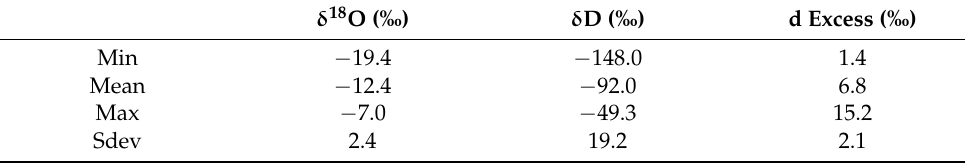
Table 3. Basic statistics of the stable water isotope composition of firn core OH-12 ( n = 414). δ 18 O (‰) δ D (‰) d Excess (‰)